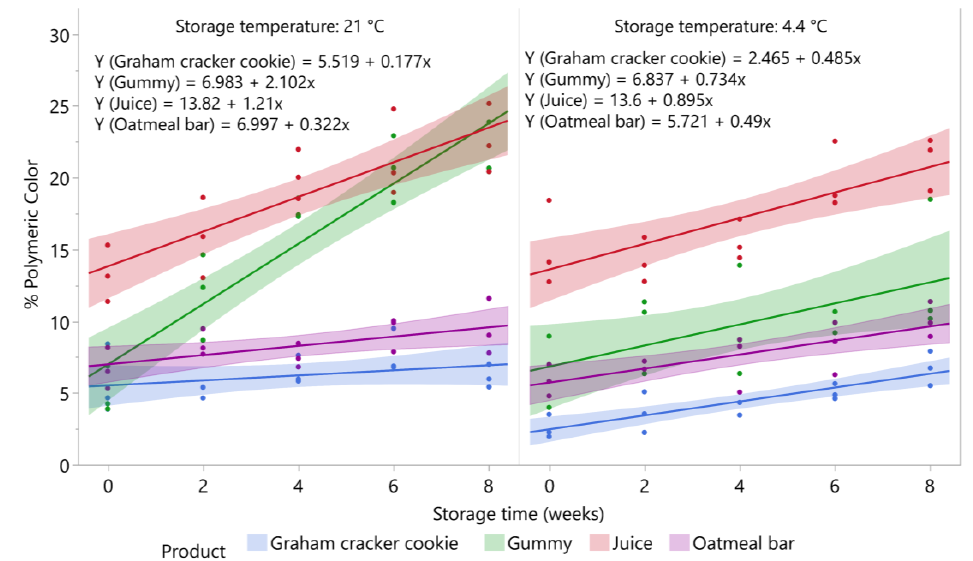
Figure 4. Stability of percent polymeric color in blueberry stored at 21 °C and 4.4 °C ( n = 3/time point). Shaded area around lines represents 95% confidence intervals for predicted values.